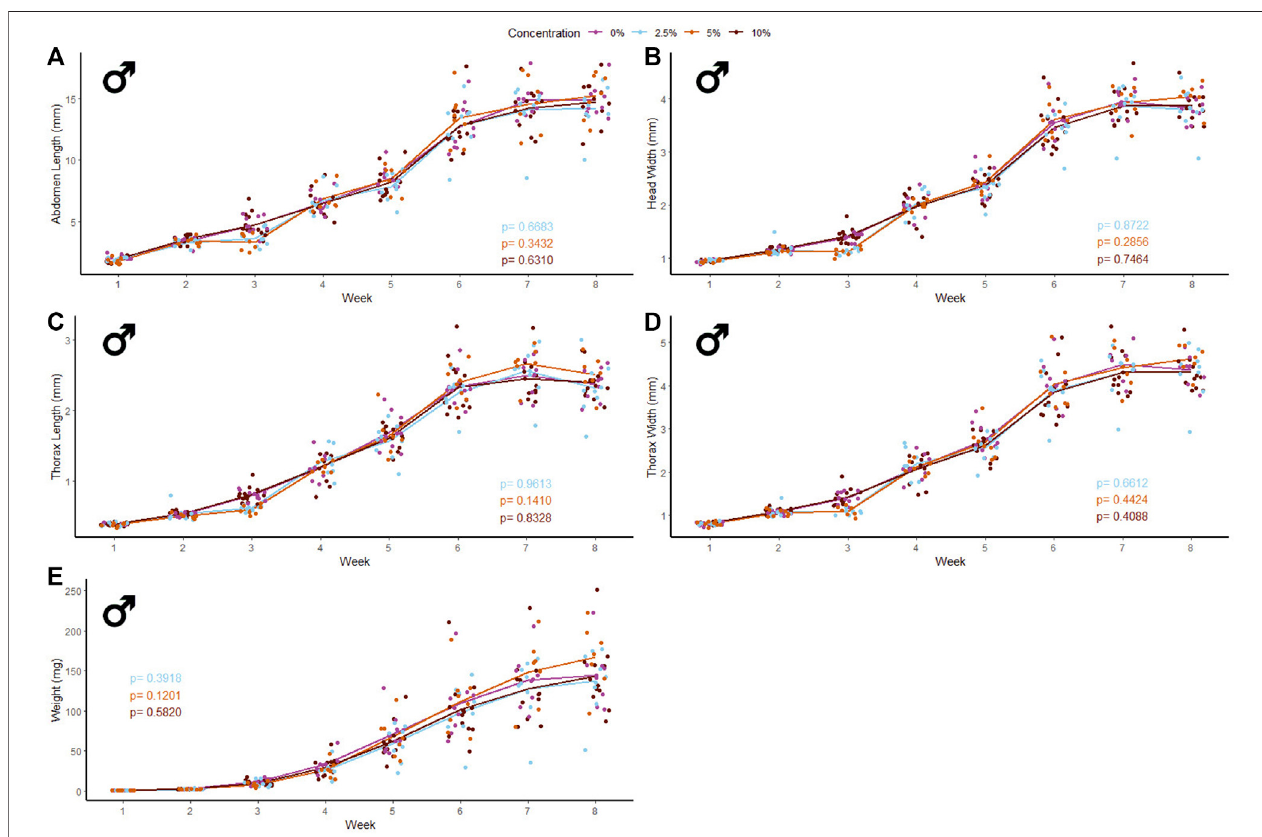
FIGURE2| Bodysizeand massofmale Gryllodessigillatus fedadiet containingPEmicrobeads.Initial measurements ofcricketsweretaken oncecricket nymphs emergedfromeggsatweek1.Pointsrepresentindividualcricketmeasurementsandlinesrepresentmeanvaluesbetweenmeasurements. p -valuesarepresentedasan interaction of the concentration of PE microbeads with the week of growth. Each panel displays a different measure of body size with (A) = abdomen length, (B) = head width, (C) = thorax length, (D) = thorax width, (E) = weight.